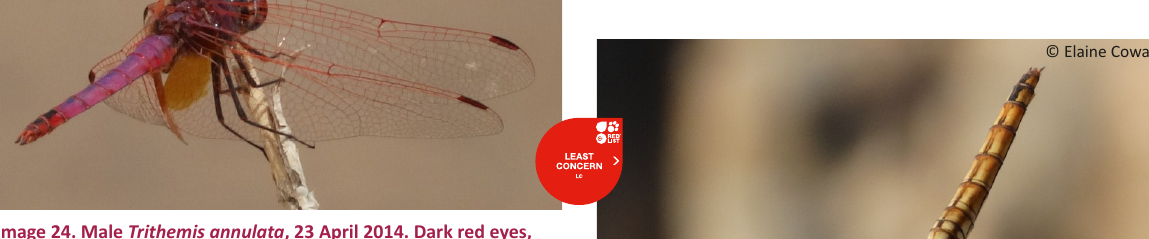
24. Male Trithemis annulata , 23 April 2014. Dark red eyes, red veins on wings with large amber patch at hindwing base. Purplish abdomen with dorsal blackish markings. This male still has some red coloration on abdomen.